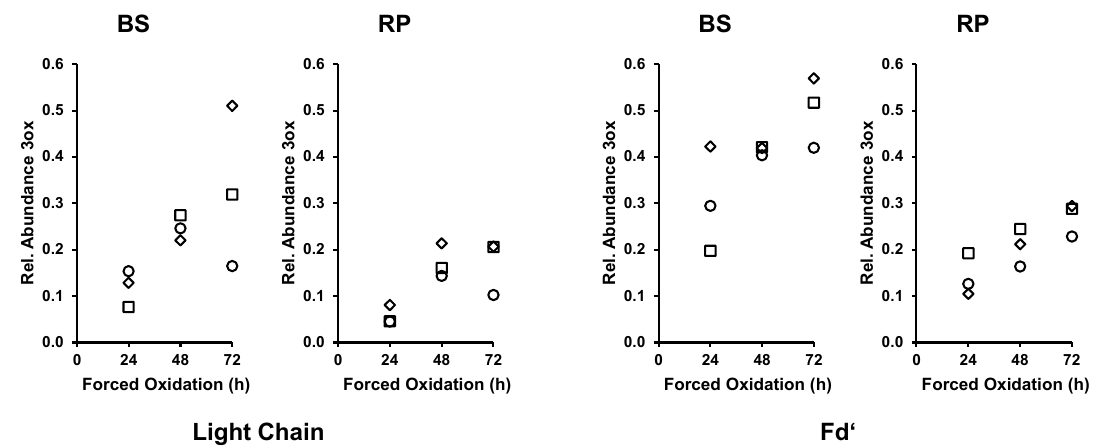
Figure 3. Time course analysis of bevacizumab biosimilar (BS) and reference product (RP) in forced oxidation samples. EICs were generated for light chain (LC) 0ox, LC 3ox, Fd’ 0ox and Fd’ 3ox and height of the EIC peak was measured. The rel. abundance 3ox was calculated using the equation given in Section 2.5. Square, circle, and diamond each represent one experimental repetition. Ox,